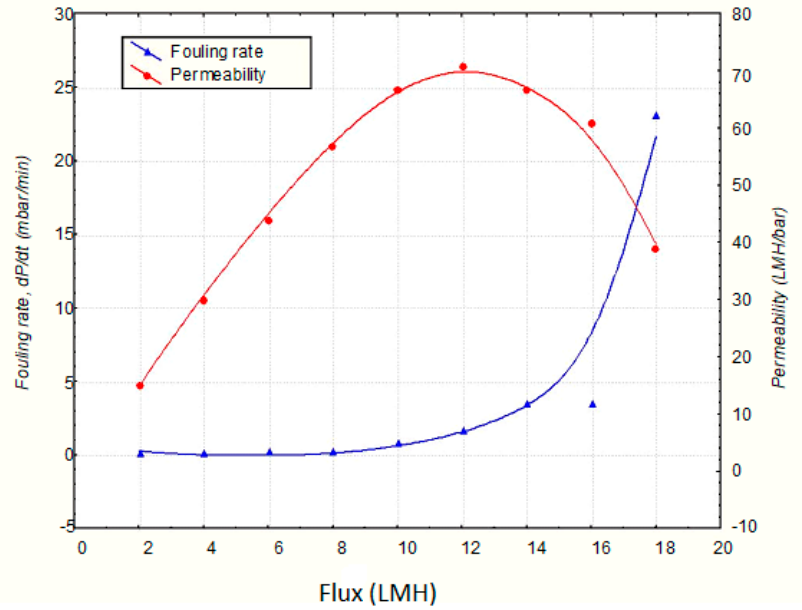
Figure 6. Relationship between the fouling rate and permeability during POME treatment using MBR